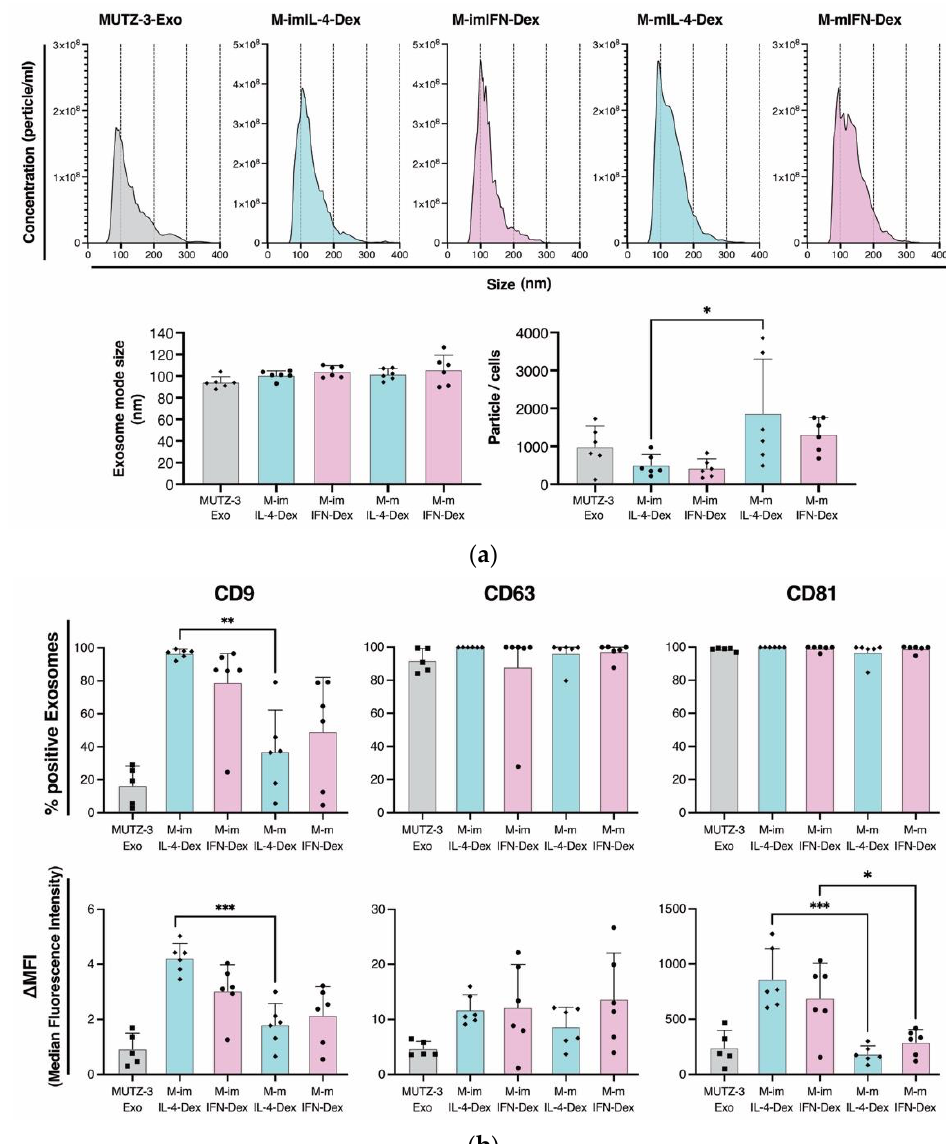
Figure 4. Characterization of MUTZ-3-derived IL-4- and IFN-DC dexosomes in immature and mature (M-imIL-4-Dex, M-imIFN-Dex, M-mIL-4-Dex, and M-mIFN-Dex, respectively). ( a ) The culture supernatants of immature and mature MUTZ-3 derived DCs were collected and the dexosomes were isolated. Size distribution, and the number of dexosomes secreted from cells identified by the nanoparticle tracking analysis ( n = 6). ( b ) The dexosomes were stained with antibodies for exosome markers and analyzed using flow cytometry. The results are shown as a percentage of positive cells and ∆ MFI. The ∆ median fluorescence intensity ( ∆ MFI) was calculated by subtracting isotype control MFI values from observed values. * p < 0.05, ** p < 0.01, and *** p < 0.001 indicate statistically significant differences ( n = 6). The bars indicate the mean ± S.D. of independent experiments. The rhombus in the Scatter plot is MUTZ-3 derived IL-4-DCs. Circle is MUTZ-3 derived IFN-DCs. Square is MUTZ-3